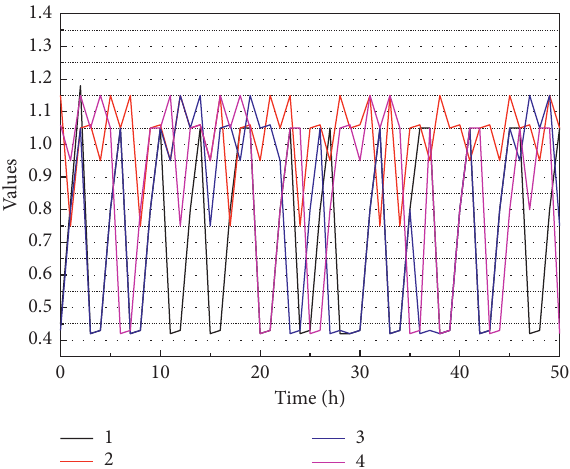
Figure 7: Changes in the expected returns of penalties under different levels of